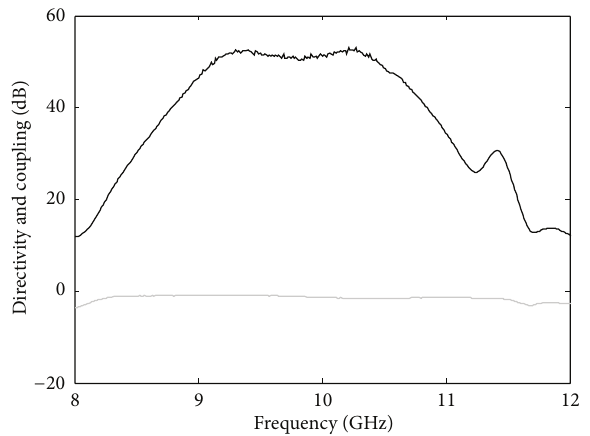
Figure 7: Simulation (thin line) and measurement (thick line) of the group delay of the 𝑆 31 parameter in the dispersive delay line of Figure 5.